Question: Generate an informative caption for the figure above.
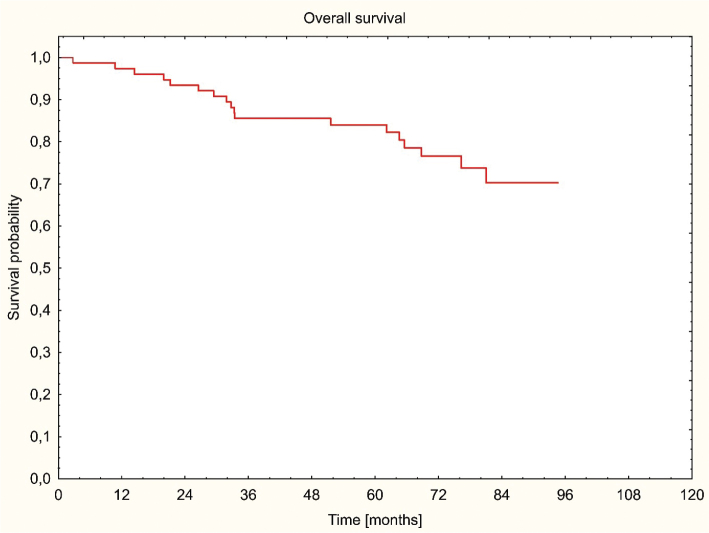
Answer: Kaplan–Meier curves for Overall Survival (OS) in chondrosarcomas and chordomas.